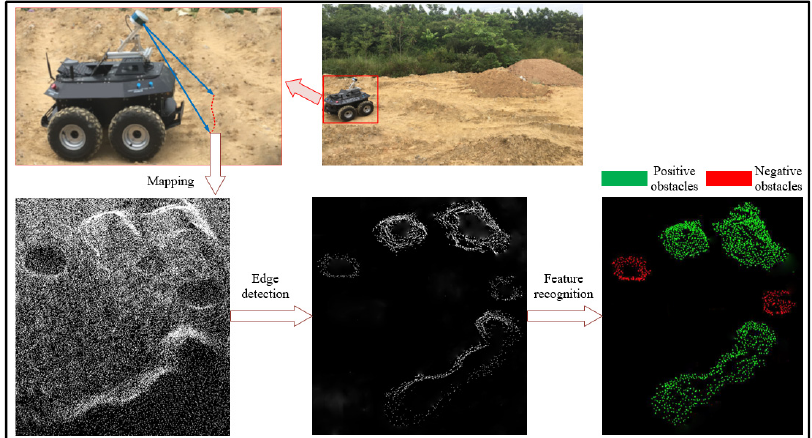
Figure 20. Results for obstacles detection on real unstructured terrain point cloud.